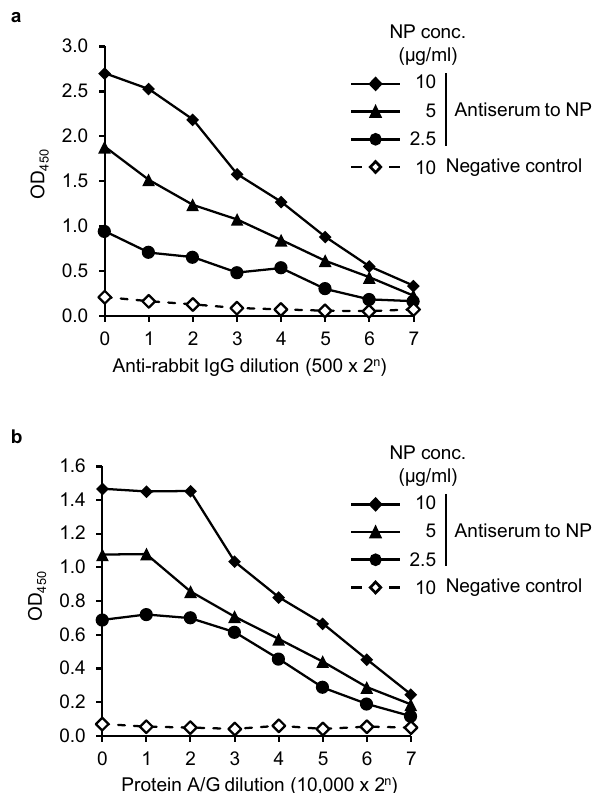
Figure. 5. Detection of CCHFV NP-specific IgG using rabbit antiserum. ELISA plates were coated with the indicated concentrations (conc.) of purified NP and 1:1000 dilutions of the rabbit antiserum and negative control serum were used as primary antibodies. Serial dilutions of the HRPO-conjugated anti-rabbit IgG antibody ( a ) or the protein A/G reagent ( b ) were used for the detection of bound NP-specific antibodies.